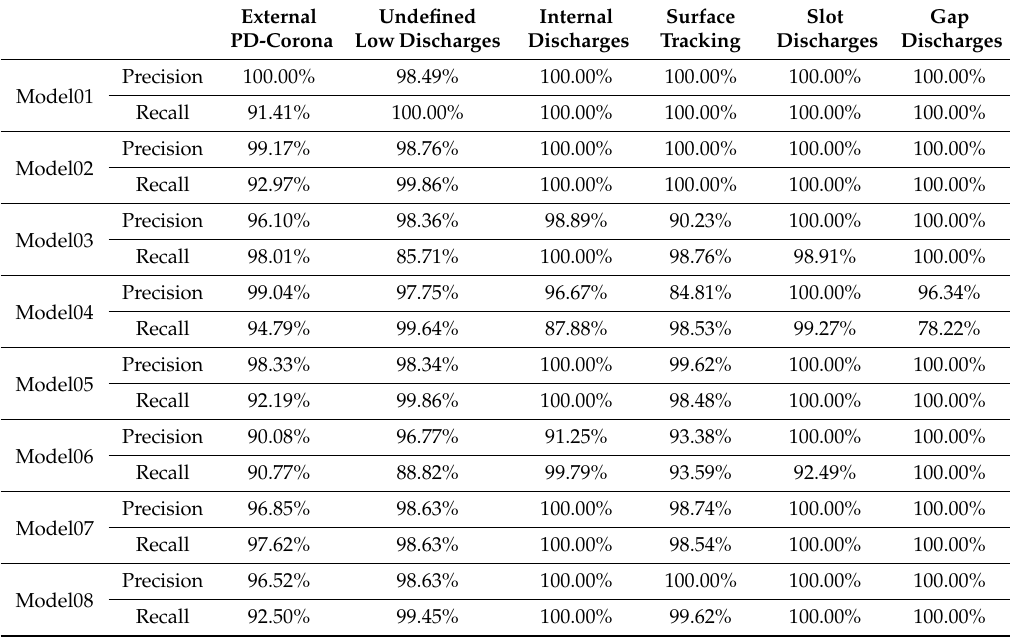
Table 2. Results of the confusion matrices generated for each